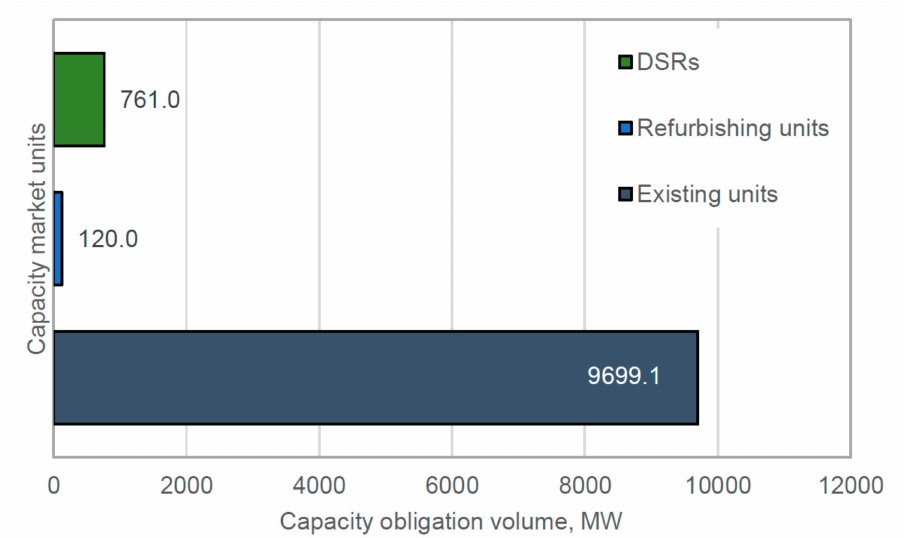
Figure 6. Capacity obligation volume contracted in main capacity auction for 2022 delivery year– break down by official (declared) assignments to capacity market units. Source: Own analysis based on [38].